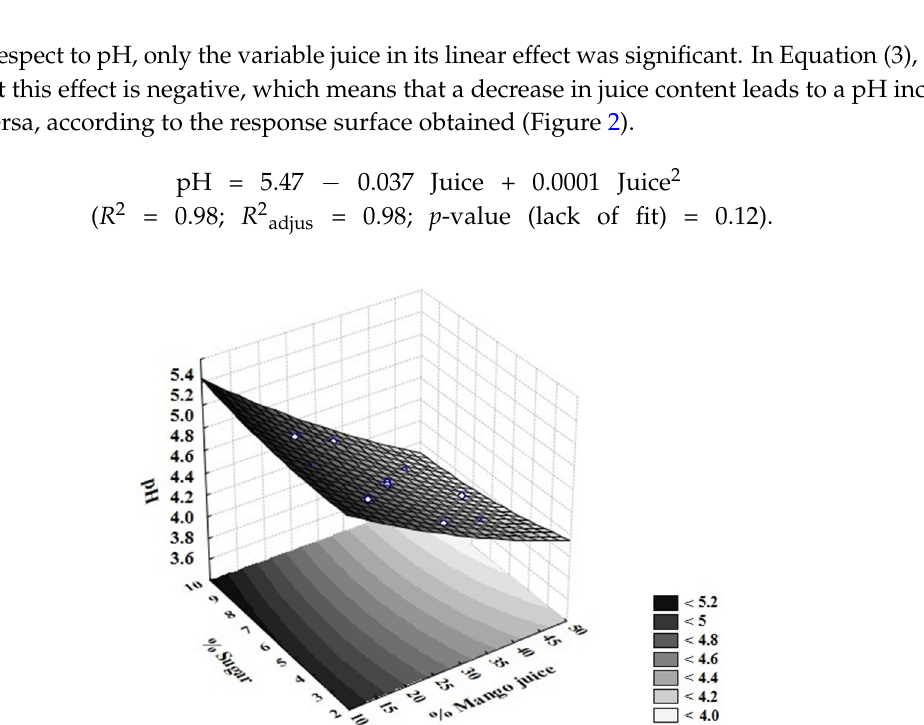
Figure 1. Effect of the addition of sugar and mango juice on the concentration of soluble solids.